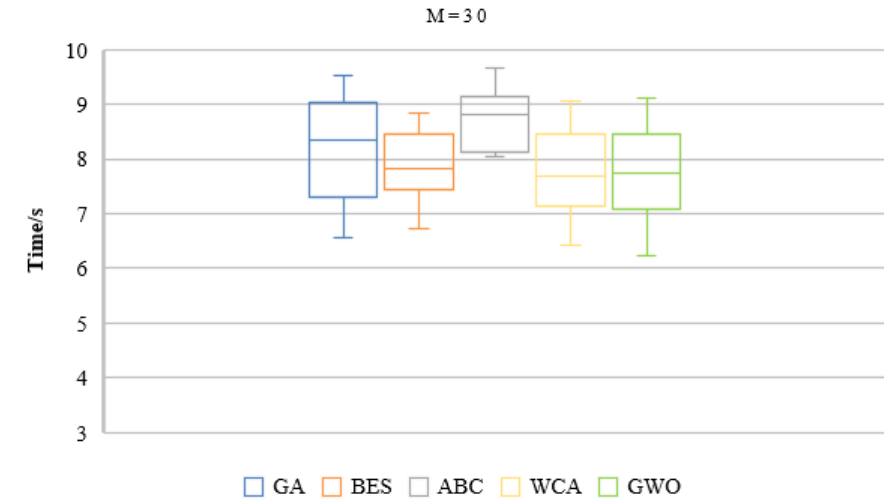
Figure 16. Running time box plot when the population is 30.